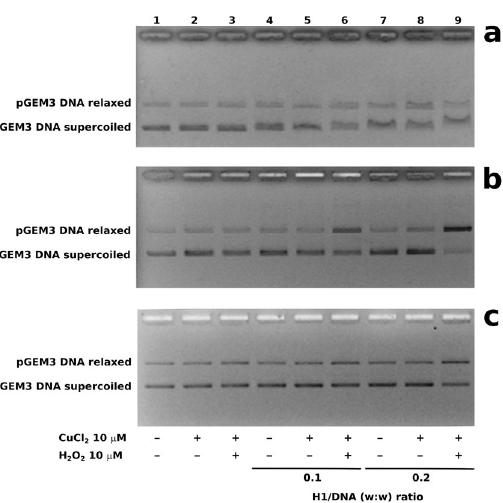
Figure 1. DNA binding affinity of H1 histones in absence and presence of 10 µ M CuCl 2 analized by EMSA. Samples containing pGEM3 plasmid DNA, incubated with increasing amount of ( a ) somatic H1 histones, ( b ) native sperm H1 histones and ( c ) deguanidinated sperm H1 histones, were analyzed by 1% agarose gel electrophoresis. ( d ) AU-PAGE of native and deguanidinated sperm H1 histones.